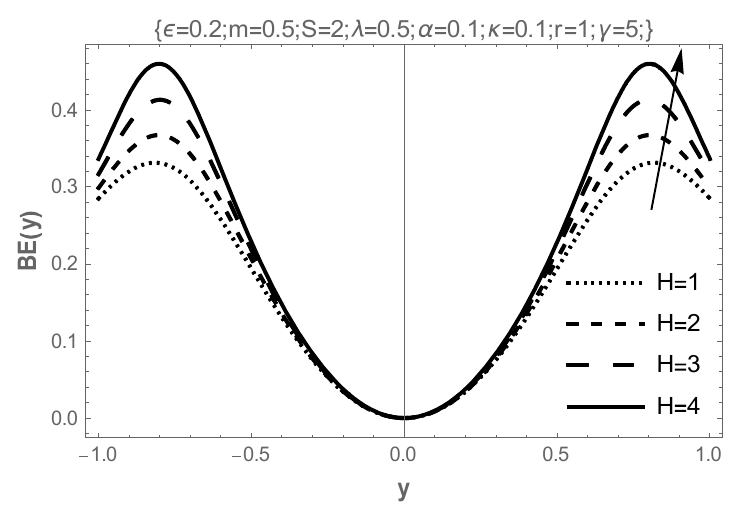
Figure 13. Effect of Hartmann number on Bejan profile.